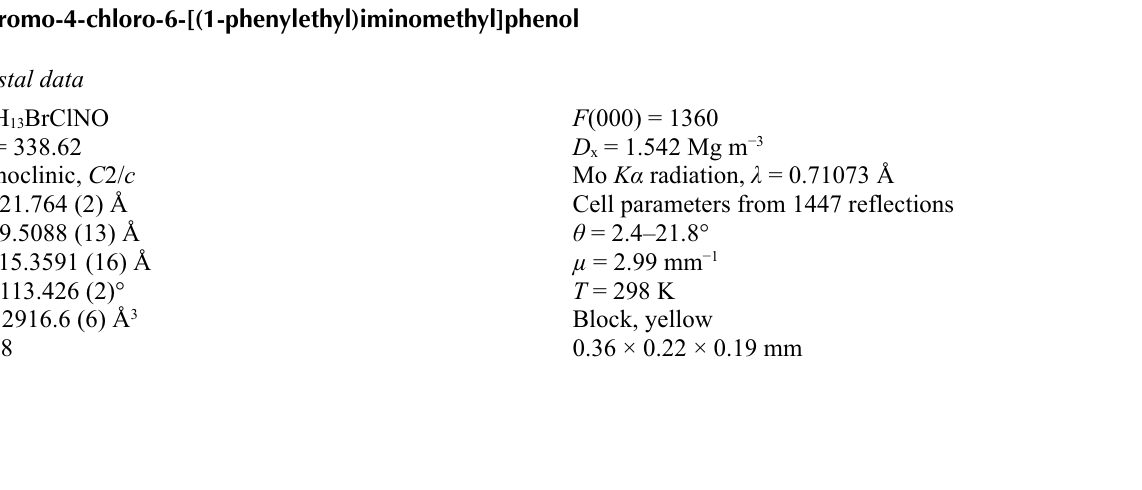
The molecular packing of (I) viewed along the b